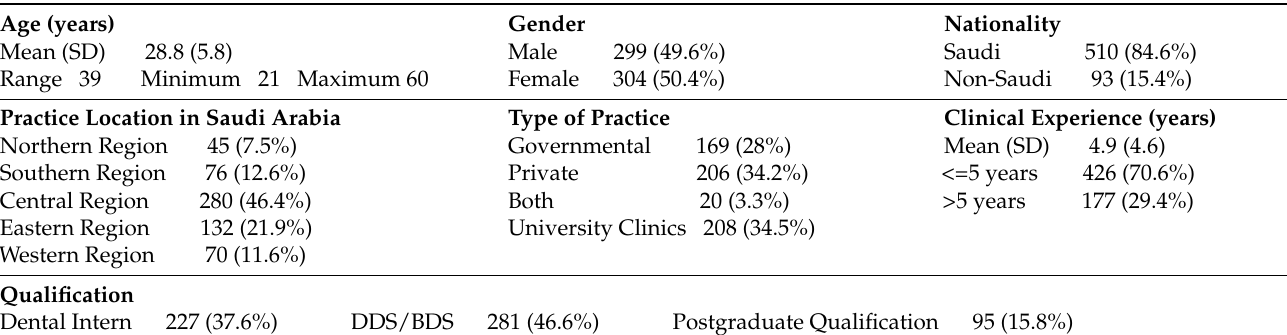
Table 1. Characteristics of participants ( n =